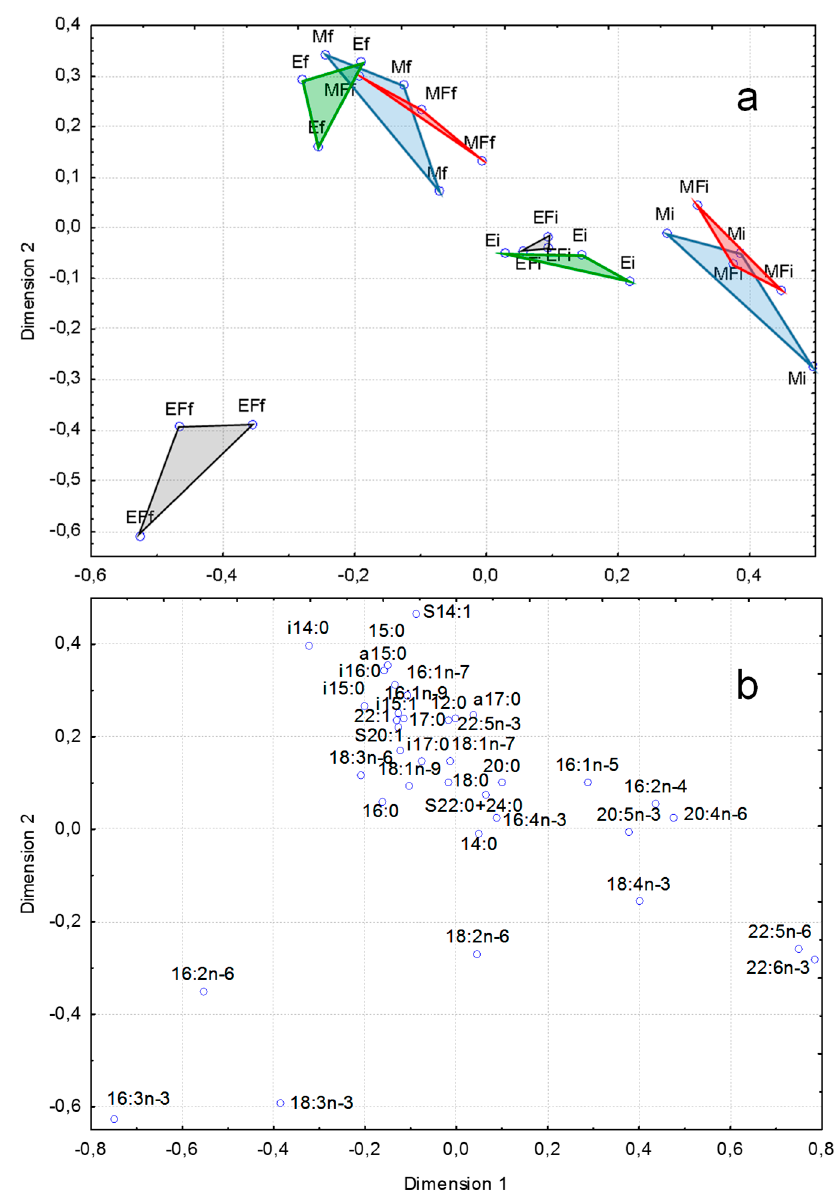
Figure 4. Results of canonical correspondence analysis of fatty acid (FA) composition (% of total FAs) of seston: E—eutrophic, M—mesotrophic conditions, F—fish, initial (June) date, f—final (July) date. a—ordination of seston samples according to their FA composition; b- ordination of sestonic FAs.